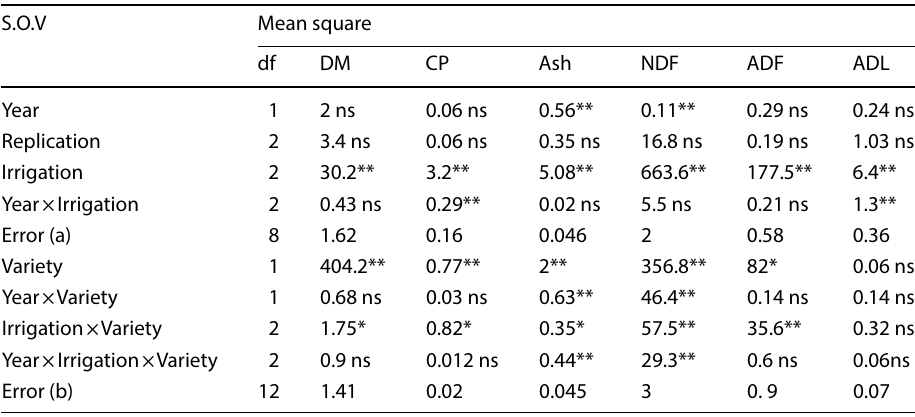
Table 4 Variance analysis of some biochemical and water productivity traits in maize varieties under irrigation levels